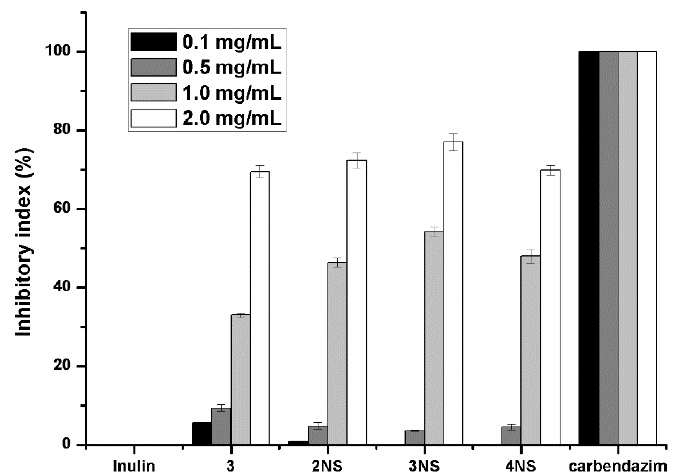
Figure 5. Antifungal activity of inulin and the inulin derivatives against B. cinerea .